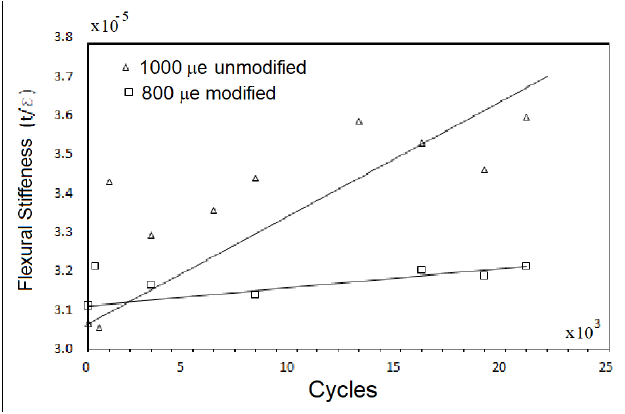
Figure 26. Comparison of the change in flexural stiffness during the slamming test with 0.27 × 10 5 cycles.